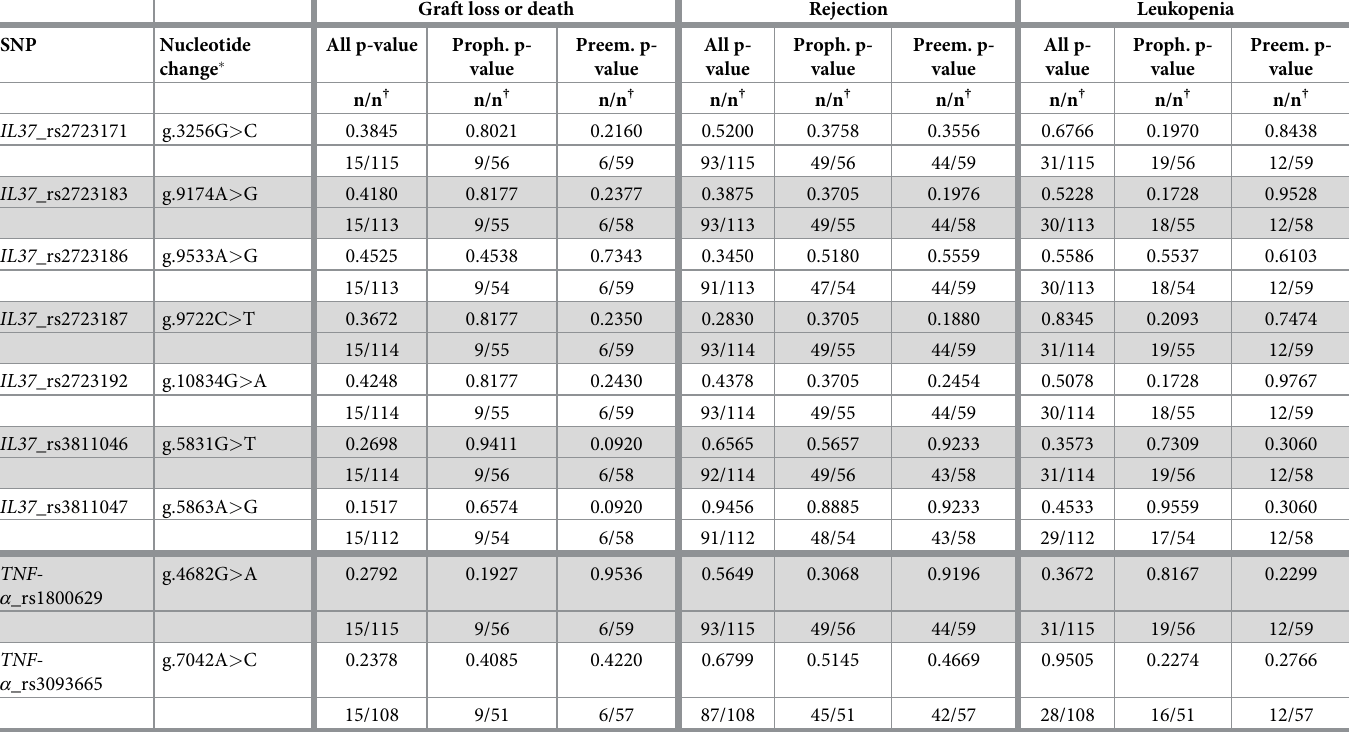
CMV infection: 39.7% in the preemptive group vs. 11.5% in the prophylaxis group; p < 0.0001) [10]. The percentages of CMV disease events were lower in this substudy than in the overall population (incidence of CMV disease in VIPP study after 84 months: 15.9% in the preemptive group vs. 4.7% in the prophylaxis group; p < 0.01). Due to the low numbers of CMV disease events, analyses of CMV disease in the prophylaxis group (two events) were excluded from the Bonferroni